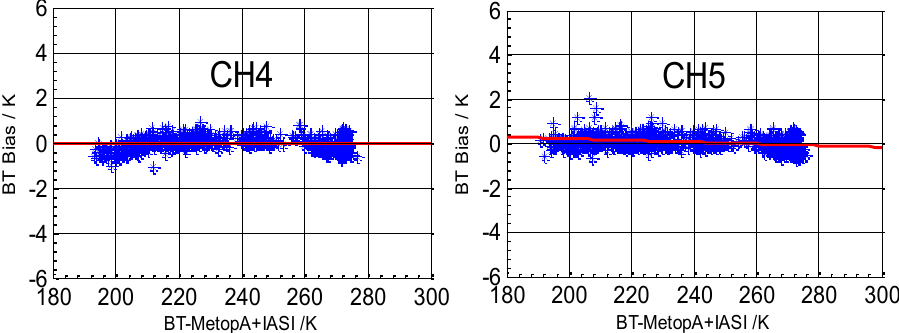
Figure 10. BT biases of FY-3A/VIRR, in August 2012, vs. IASI (VIRR-IASI) using new nonlinear correction coefficients. The solid lines are linear regression results as a function of temperature.